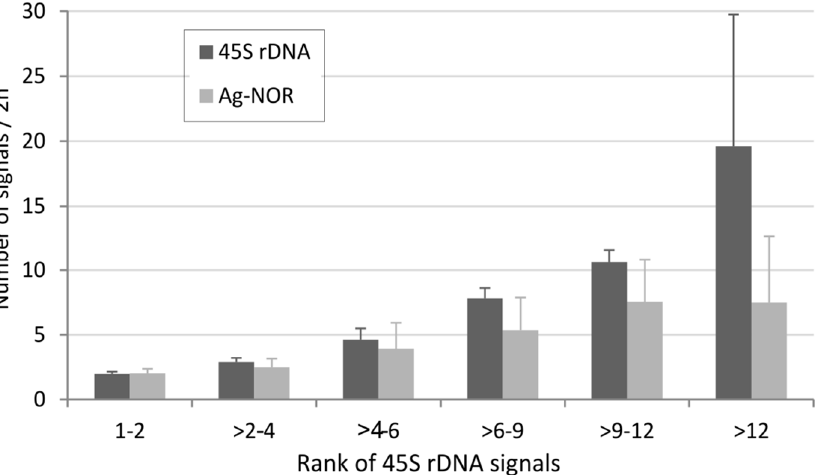
Figure 4. Relationship between the number of 45S rDNA loci and the number of Ag-NOR signals. The average number of Ag-NOR signals and loci was counted in each group differing in locus number (x-axis) and expressed as an average (y-axis). The number of karyotypes in each group was as follows: 753 (group “1–2”), 60 (“>2–4”), 237 (“>4–6”), 44 (“6–9”), 32 (“>9–12”), and 31 (“>12”).